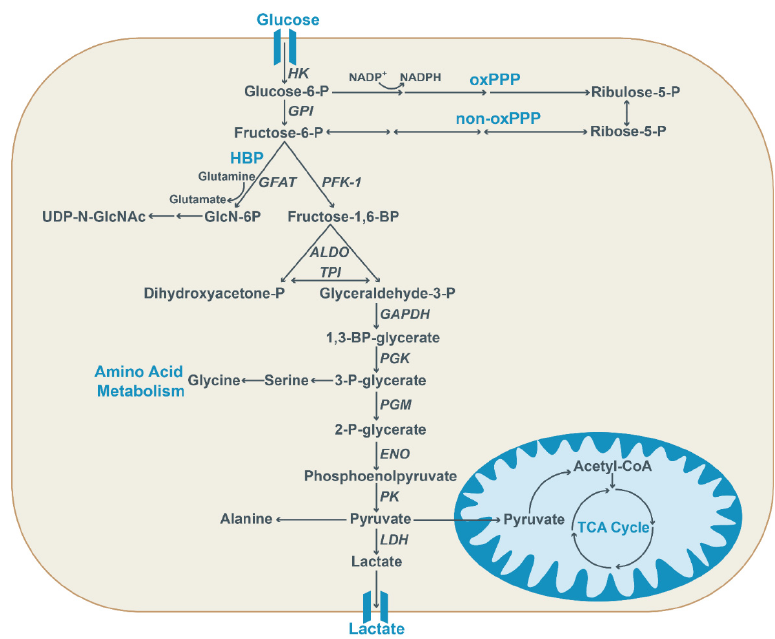
Figure 1. Glycolysis provides important intermediates for anabolic processes. Glucose is trans- ported into the cell via glucose transporters and first converted into glucose-6-phosphate by hexo- kinase (HK) and subsequently converted into fructose-6-phosphate. Alternatively, it acts as a substrate for the oxidative pentose phosphate pathway (oxPPP) to generate ribulose-5-phosphate, thereby also generating reducing equivalents in the form of NADPH. Fructose-6-phosphate is con- verted into fructose-1,6-phosphate by phosphofructokinase 1 (PFK-1) or it can be utilized in the non-oxidative pentose phosphate pathway (non-oxPPP), ultimately resulting in ribose-5-phosphate generation. Moreover, the hexosamine biosynthetic pathway (HBP) utilizes fructose-6-phosphate, together with glutamine, to generate glucosamine-6-phosphate (GlcN-6P) via glutamine:fructose- 6-phosphate aminotransferase (GFAT). Subsequently, the end product UDP-N-acetylglucosamine (UDP-N-GlcNAc) is generated in a multi-step conversion. Glyceraldehyde-3-phosphate generated by aldolase (ALDO) and triose-phosphate isomerase (TPI) further undergoes glycolysis. After conver- sion into 1,3-BP-glycerate via glyceraldehyde-3-phosphate-dehydrogenase (GAPDH), the glycolytic intermediate 3-P-glycerate is generated via phosphoglycerate kinase (PGK) and converted into pyru- vate by pyruvate kinase (PK). It can also be used for the synthesis of amino acids. Pyruvate is either converted into lactate by lactate dehydrogenase (LDH), used to generate amino acids, or enters the mitochondria to fuel the TCA